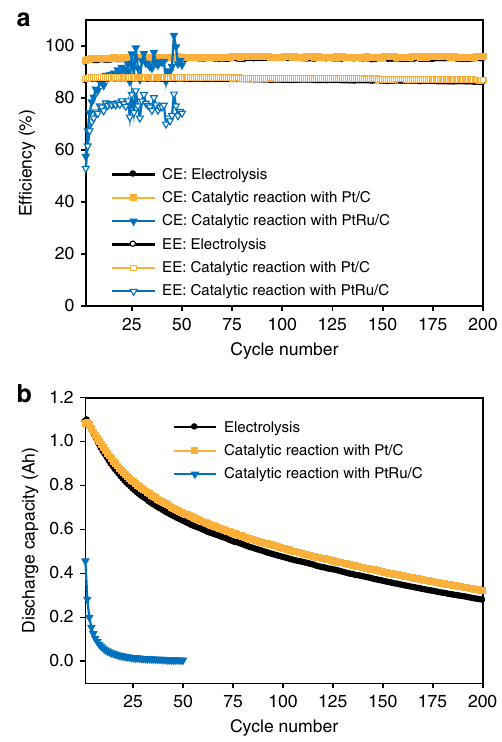
Fig. 5 Electrochemical performance of the V 3.5 + electrolyte. a Coulombic ef fi ciencies (CEs), energy ef fi ciencies (EEs), and b discharge capacities of cells cycling at 80 mA cm − 2 using electrolytes produced by catalytic reaction using Pt/C and PtRu/C, and by